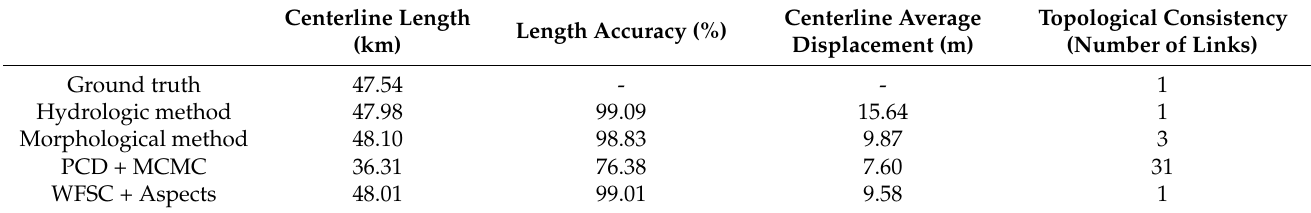
Table 3. The accuracy of centerline delineation using the four methods in this